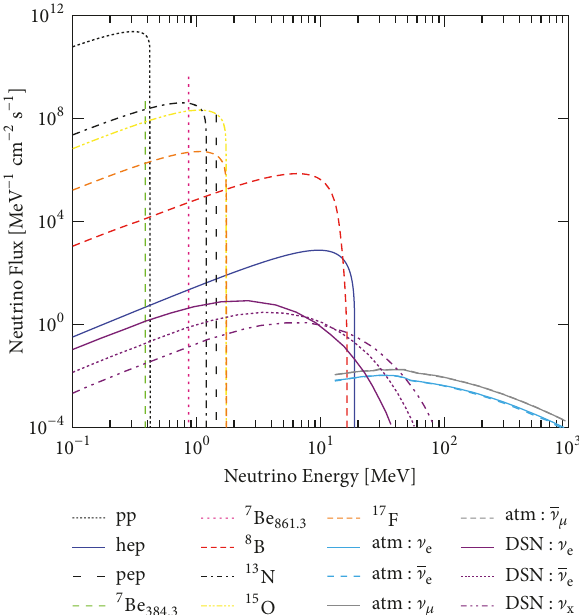
Figure 1: Unoscillate neutrino flux considered in the present study, including the Solar, Atmospheric, and DSNB